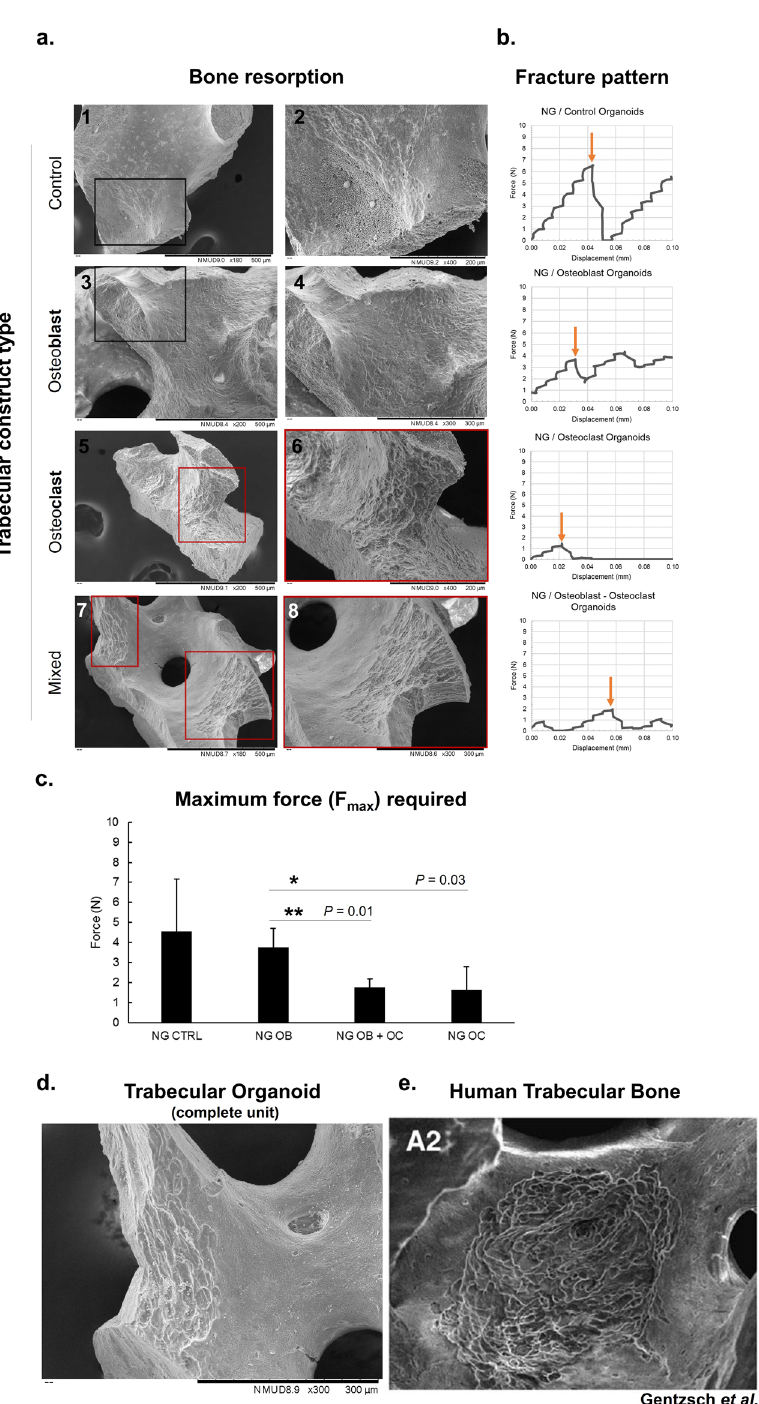
Fig. 4 Simulating bone loss in constructs and the effects on local mechanics. Resorption of the bone surface was investigated on trabeculae from different cell-seeded groups after 8 days of culture to detect the manifestations in each type of condition. Cell-free constructs and those that were cultured with osteoblasts show only signs of endogenous resorption, originating from the native bone tissue ( a -1,2 and 3,4, respectively). Osteoclast-cultured constructs show a signi fi cant pattern of resorption ( a -5, 6), which was observed in mixed constructs as well ( a -7, 8), developed with both osteoblastic and osteoclastic cells. Dark boxes = areas of no resorption; red boxes = areas of resorption. The mechanical properties of these groups were investigated by subjecting the cultured constructs to compressive forces and observing the fracture patterns, related to their trabecular distribution ( b ), and changes in maximum force required to collapse the structure, a feature related to their integrity ( c ). The values selected for comparison, for which representative examples are presented in b with orange arrows, were chosen as the maximum compressive force that can generate the ultimate structural failure. The least-resistant organoids were those that contained mixed osteoblasts-osteoclasts and osteoclasts alone (** p = 0.01 and * p = 0.03, respectively, n = 3), which required signi fi cantly less force to reach terminal failure. Data is presented as mean ± SD. The resorptive patterns encountered in mixed constructs simulating a whole remodelling unit ( d ) were reticulate in appearance, similar to those encountered in human trabecular bone from femoral heads. Figure e is taken from Gentzsch et al. 75 by permission from Springer Nature. Scale bars as